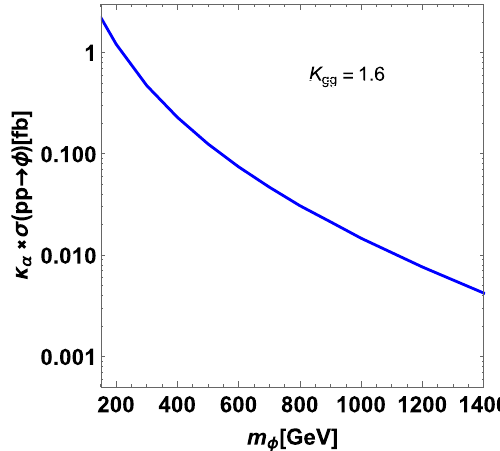
Fig. 5 The cross section for pp → φ as a function of m φ which is multiplied by scaling factor κ α = ( sin α/ 0 . 01 ) − 2 , and